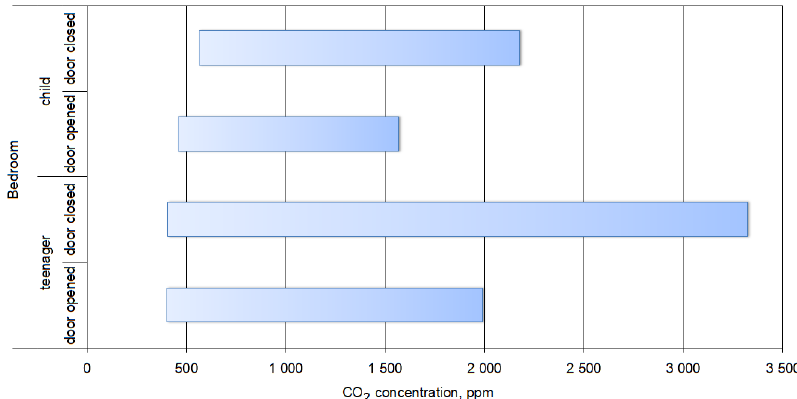
Figure 2. CO 2 concentration inside the teenager’s and child’s bedrooms during the night.